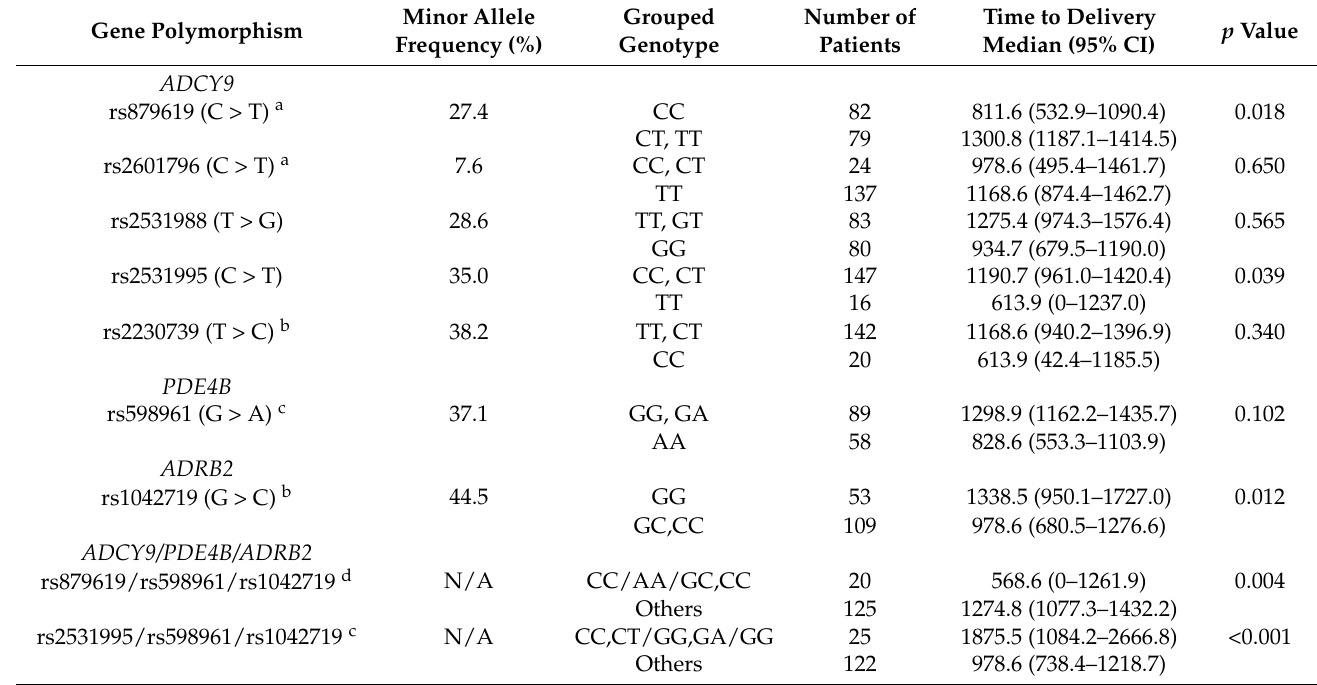
Table 2. Effects of grouped genotypes on time to delivery.